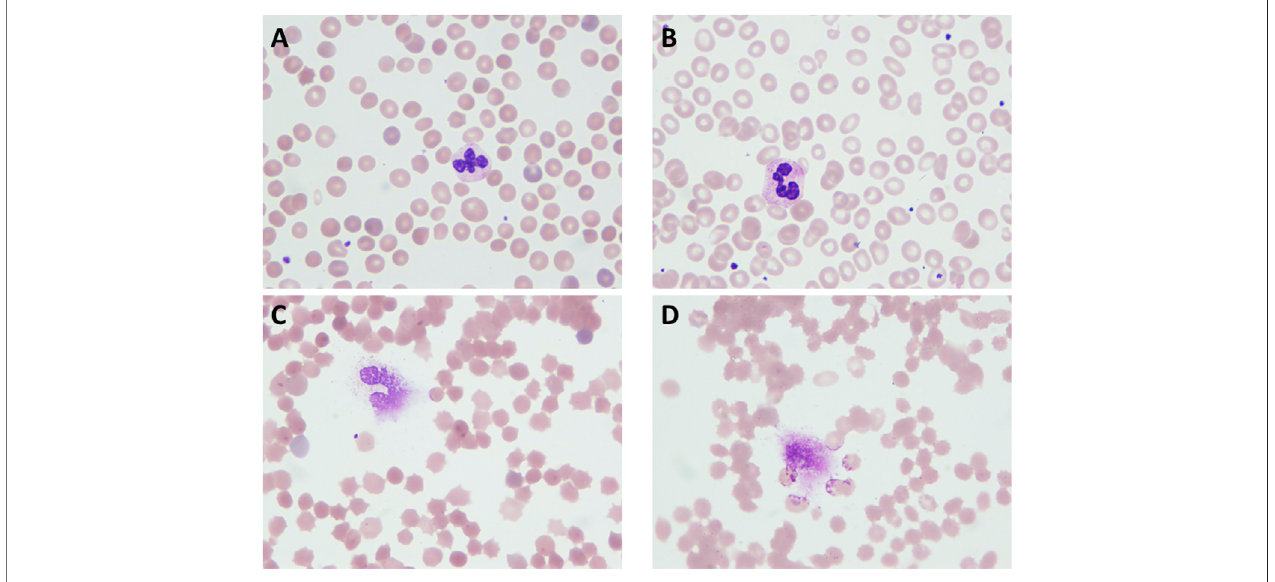
FIGURE1| HSpatientandnormalerythrocyticpatientbloodcellsmearslides. (A) BloodsamplefromHSpatient ’ speripheralveinbeforesurgery; (B) bloodsample from a normal erythrocytic patient ’ s peripheral vein before surgery; (C) blood sample from an HS patient ’ s Cell Saver salvaging system collection bag; (D) blood sample from a normal erythrocytic patient ’ s Cell Saver salvaging system collection